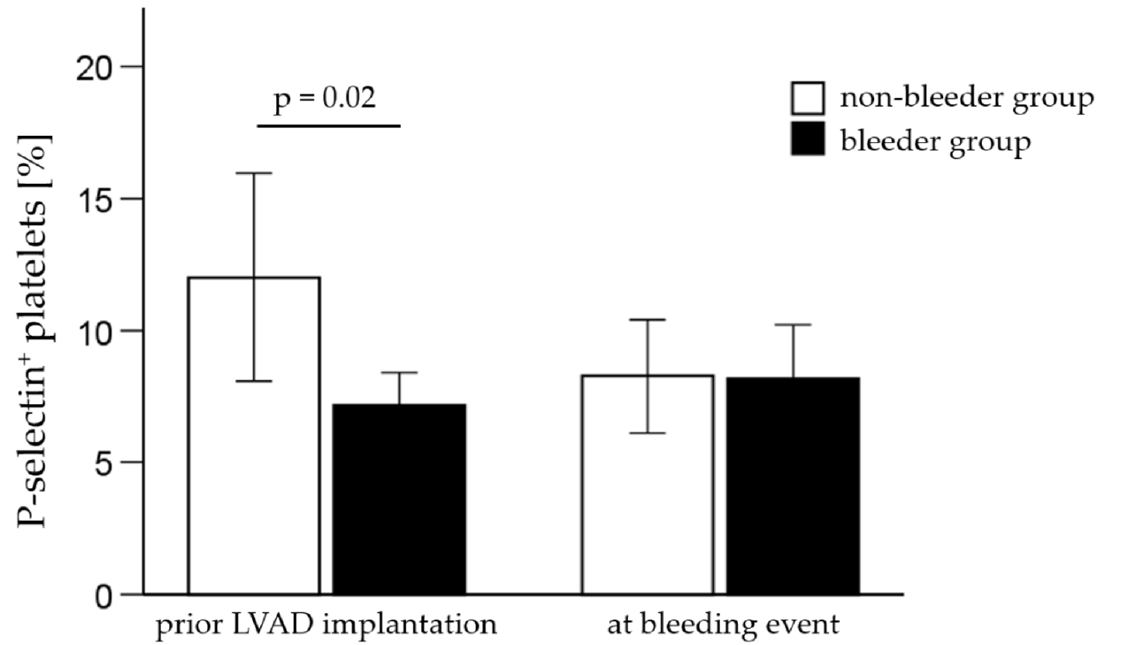
Figure 2. The percentage of P-selectin-positive platelets in patients with (bleeder) and without bleeding complications (non-bleeder) prior to LVAD implantation and at the timepoint of the first bleeding event. All values are expressed as mean ± standard error. p ≤ 0.05 is considered statistically significant.